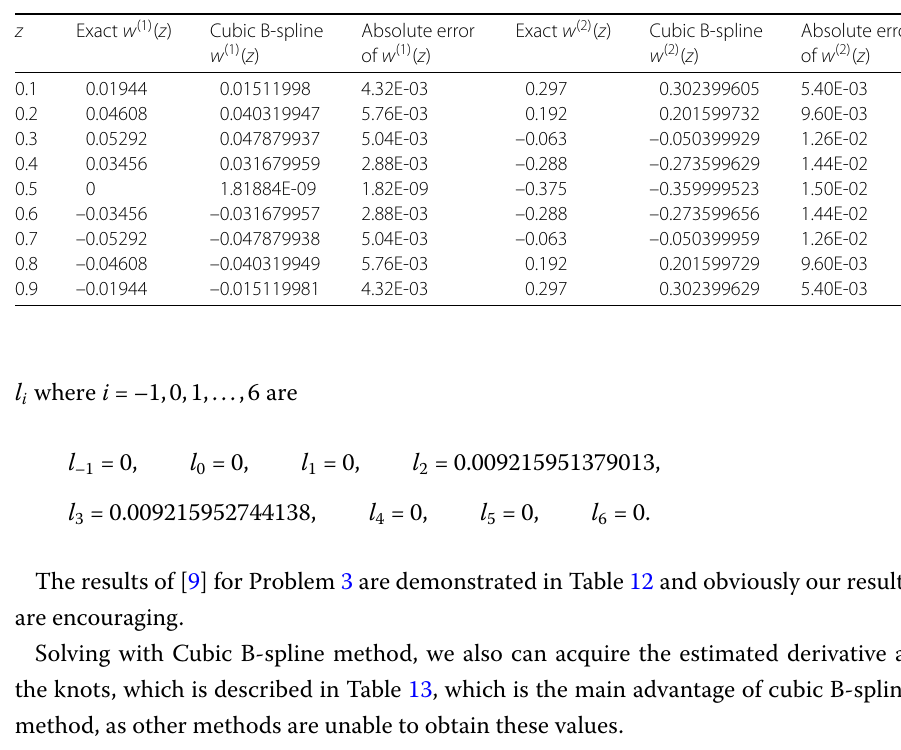
Table 13 Estimated derivative at the knots for Problem